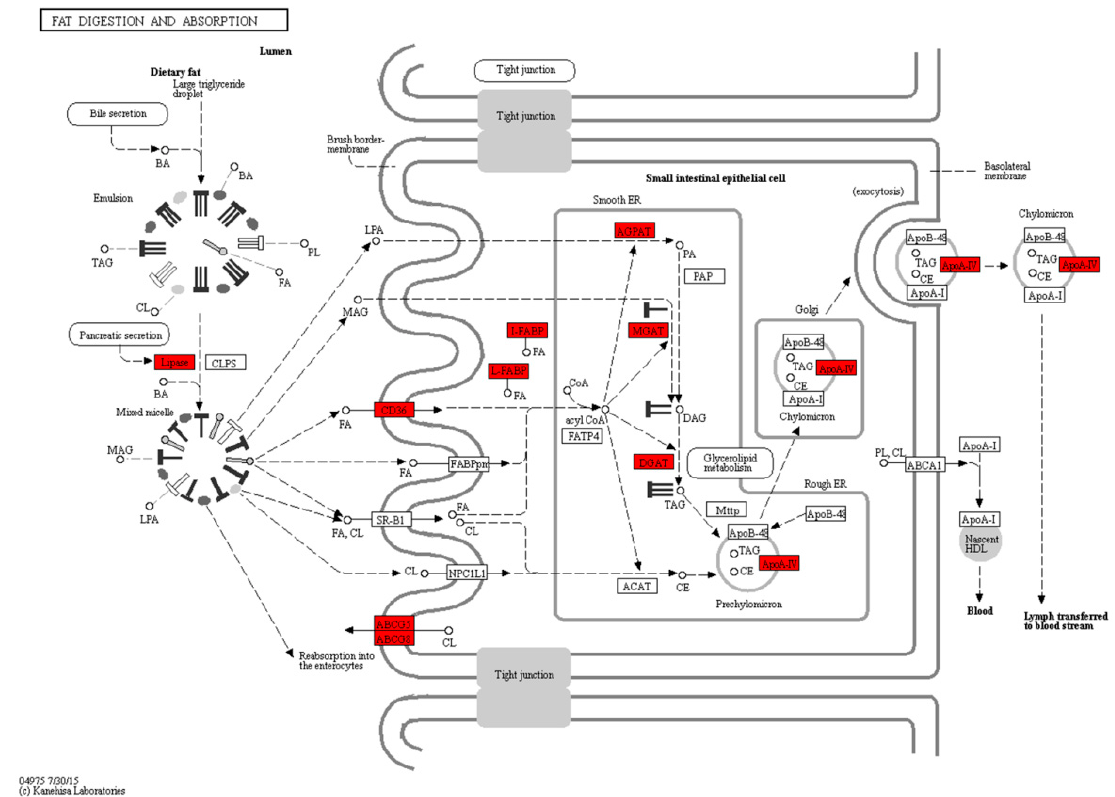
Figure 5. The differentially expressed genes involved in the fat digestion and absorption were annotated by KEGG. Red indicates up-regulated genes. The DEGs included cel.1 , cel.2 , pla2g12a , pla2g1b , pla2g3 , fabp2 , fabp6 , fabp1b.1 , fabp10a , cd36 , agpat2 , mogat2 , dgat1a , apoa4a , apoa4b.2 , and apoa4b.3 .